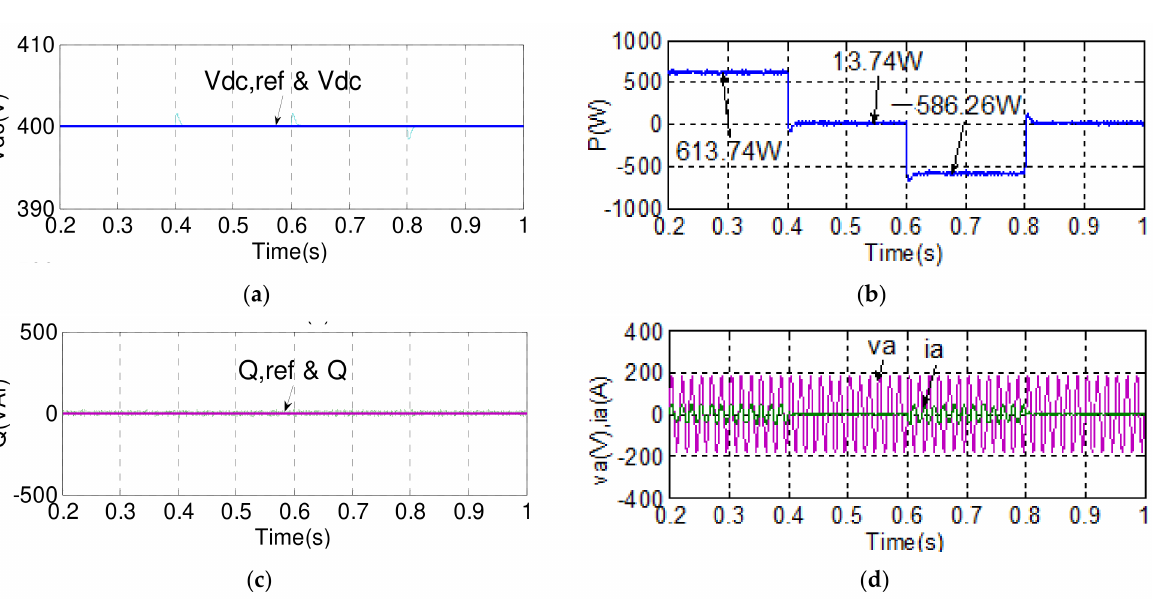
Figure 15. Simulated grid inverter waveforms in case 1: ( a ) DC link voltage and reference; ( b ) active power; ( c ) reactive power and reference; ( d ) phase-a voltage and current waveforms.